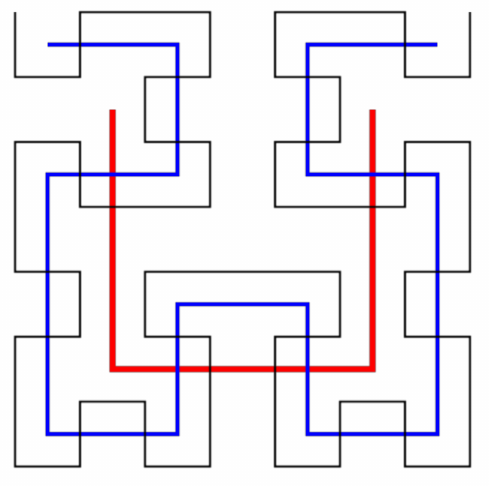
Figure 15. Hilbert curve. Table 1. Comparing studies of the two curves for displacement calculations. Method First Second Third Average Convert Hilbert curve to (x,y)(ms) 179 182 181 180 Displacement calculation under Z-order(ms) 11 12 10